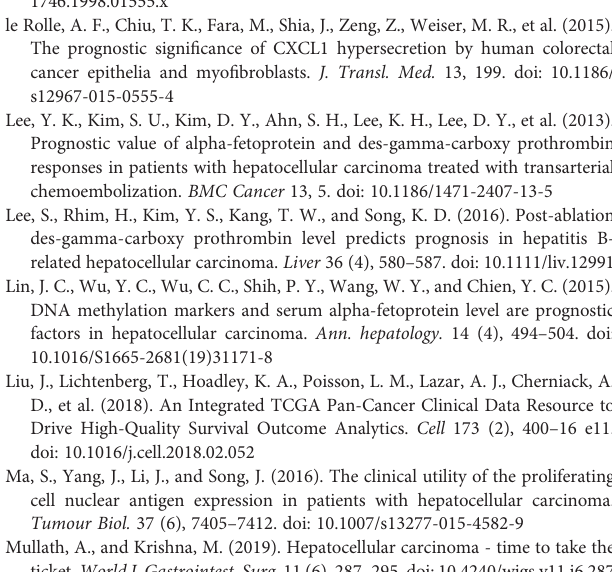
FIGURE S2 | Validation of the top three high-frequency reported biomarkers in OSlihc.Kaplan – Meierplotsfor (A – C) SPP1 , (D – F) MKI67 ,and (G – I) BIRC5 interms of DSS, DFI and PFI. FIGURE S3 | Gene expression analysis of SPP1 (A) , MKI67 (B) and BIRC5 (C) at GEPIA with comparison between tumor and normal tissues. TABLE S1 | Clinicopathologic Characteristics of LIHC patients in TCGA dataset. TABLE S2 | Clinicopathologic Characteristics of LIHC patients in GEO datasets. TABLE S3 | Validation of previously published predictors for LIHC survival in